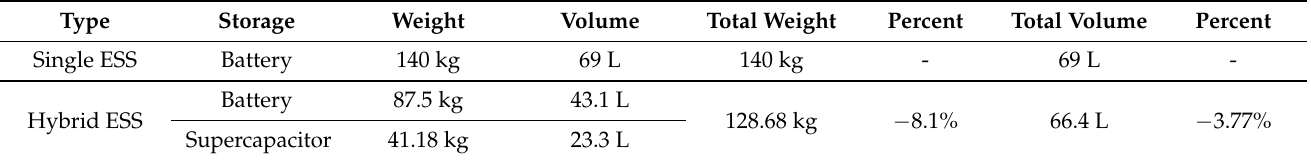
Table 7. Comparative analysis of energy storage system quality and